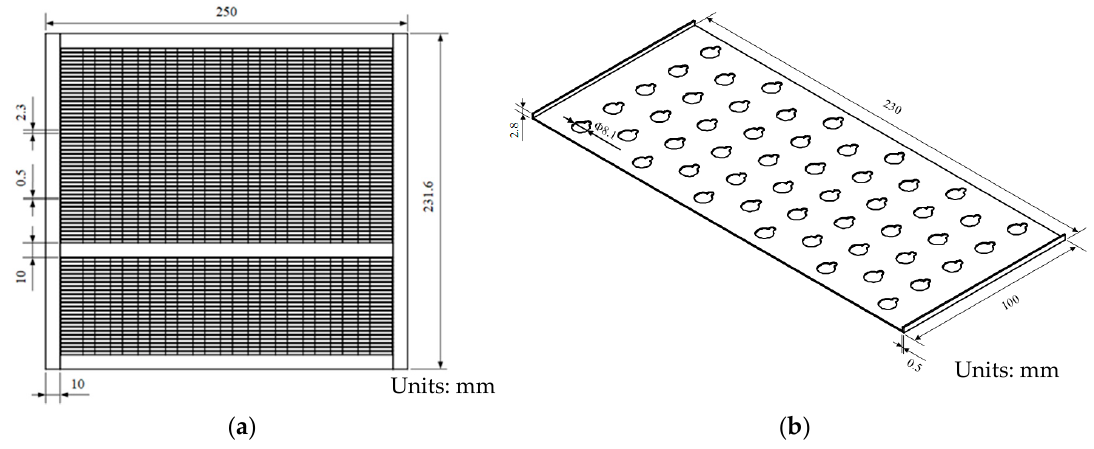
Figure 1. The schematic diagram of the ( a ) front view of the heat pipe-based desiccant device, and ( b ) one of the plate fins.